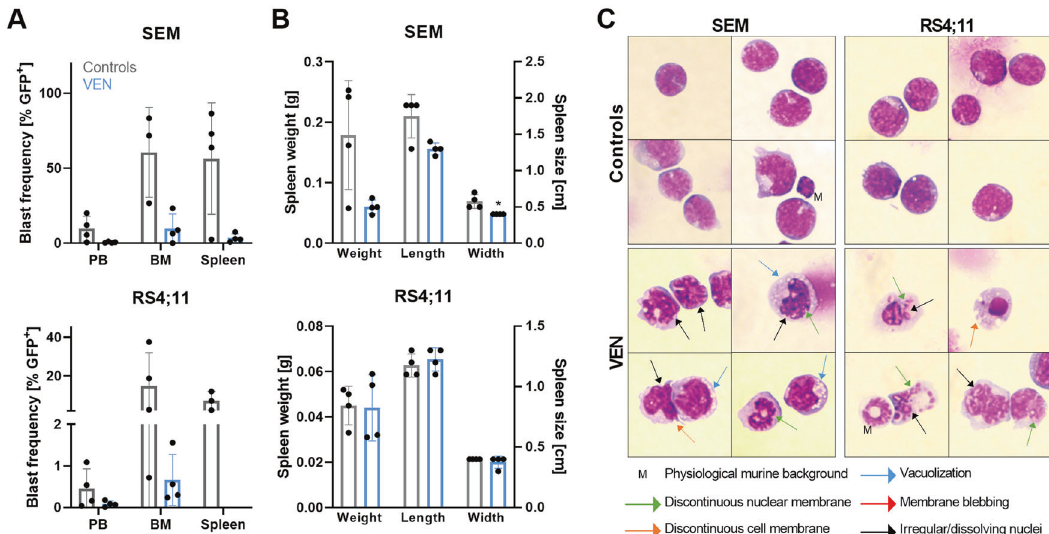
Fig. 6 Immediate effects of VEN application on cell line-based xenograft models. Four mice per study group and model system were euthanized directly after therapy cessation. A Peripheral blood (PB), bone marrow (BM), and spleen blast frequencies were assessed by fl ow cytometry. No tumor cells were detected in spleens of RS4;11-derived xenograft mice after VEN therapy. Mean ± SD; Mann – Whitney test. B Spleens were weighed and measured immediately after experiment termination. Mean ± SD; Mann – Whitney test. C Isolated BM or spleen cells were spun onto microscopic slides and Pappenheim stained. Four representative images per xenograft model and study group at 100x magni fi